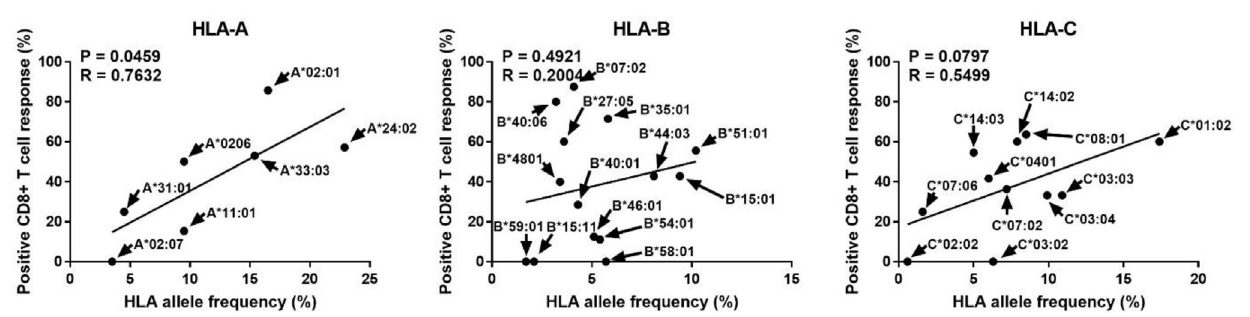
FigUre 4 | Correlation analysis of the proportion showing positive pp65­specific CD8 + T cell responses in each human leukocyte antigen (HLA) allotype with the frequencies of HLA class I alleles known in the Korean population. In the 50 donors included in this study ( Table 1 ), in total 32 allotypes of HLA class I (7 HLA­A, 14 HLA­B, and 11 HLA­C) found. The proportions showing positive CD8 + T cell responses in donors with a specific allotype are presented in Figure 3 . HLA allele frequencies in the Korean population have been quoted (22). P and R values calculated by Pearson’s correlation